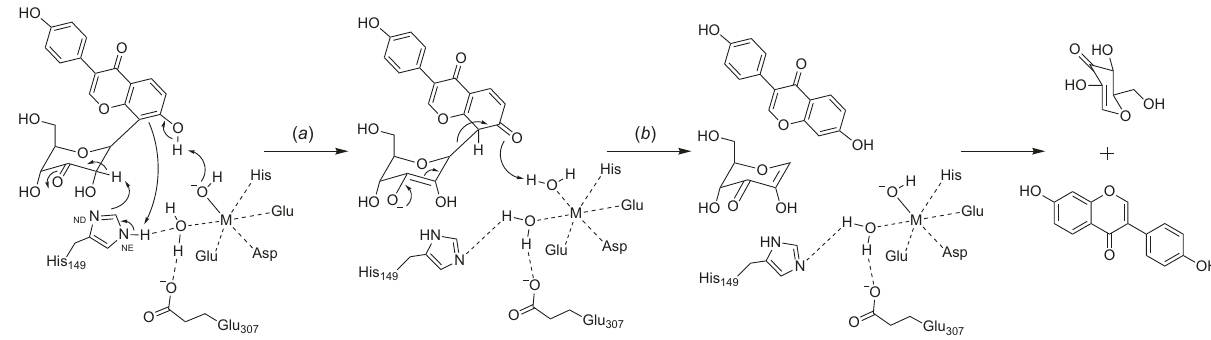
Fig. 7 Proposed mechanism of C -deglycosylation reaction. The numbering of amino acid residues in this fi gure is that for Ag CGD2. M represents a nature. Future biochemical and structural analyses of the enzymes from intestinal bacteria will provide further insights into the